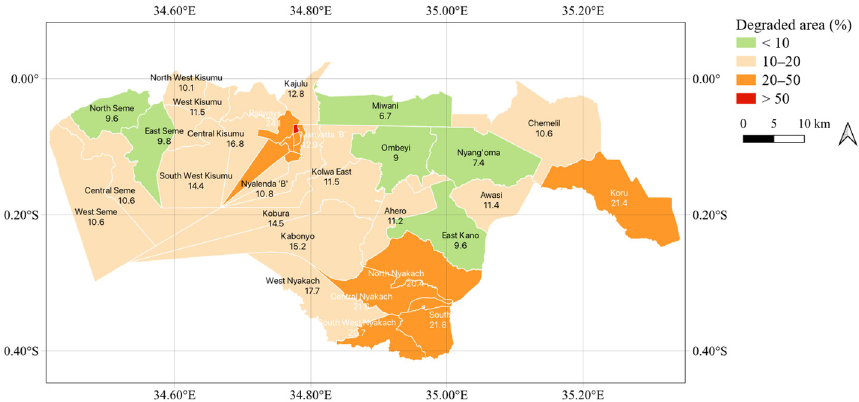
Figure 10. The proportion of degraded land (%) between 2016 and 2020 in Kisumu wards, Kenya. Next, the degraded, stable and improved land are overlayed over the parcel to pri- oritise tree and hedgerow plantation areas as high, medium and low class, respectively (Figure 11).